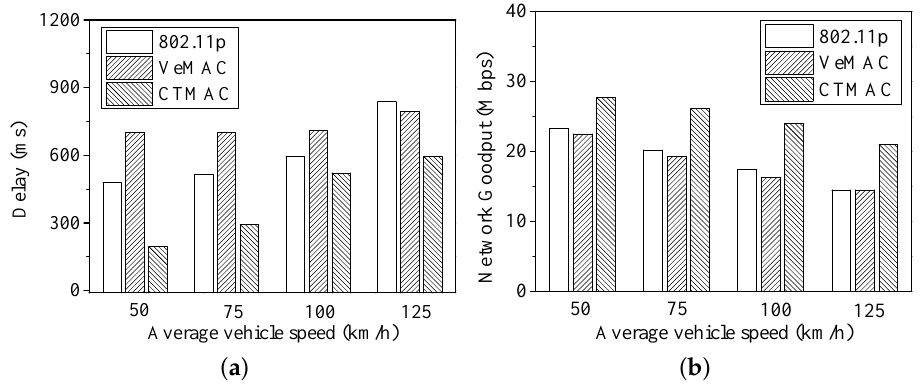
Figure 6. ( a ) Delay; and ( b ) network goodput under different vehicle